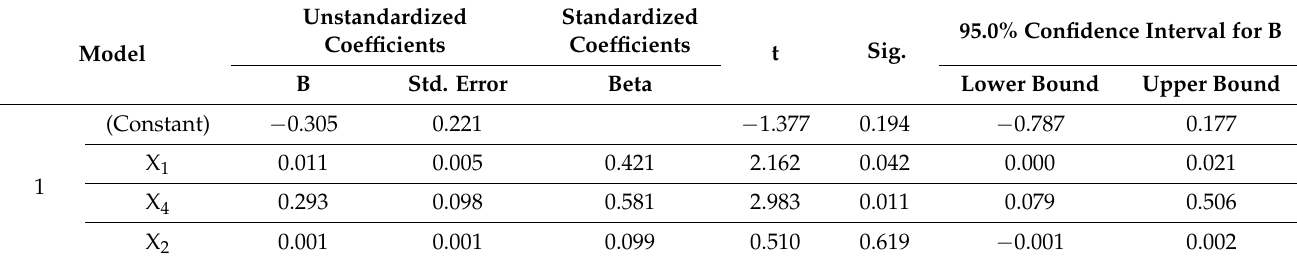
Table 9. Coefficients of predictors with three predictors.